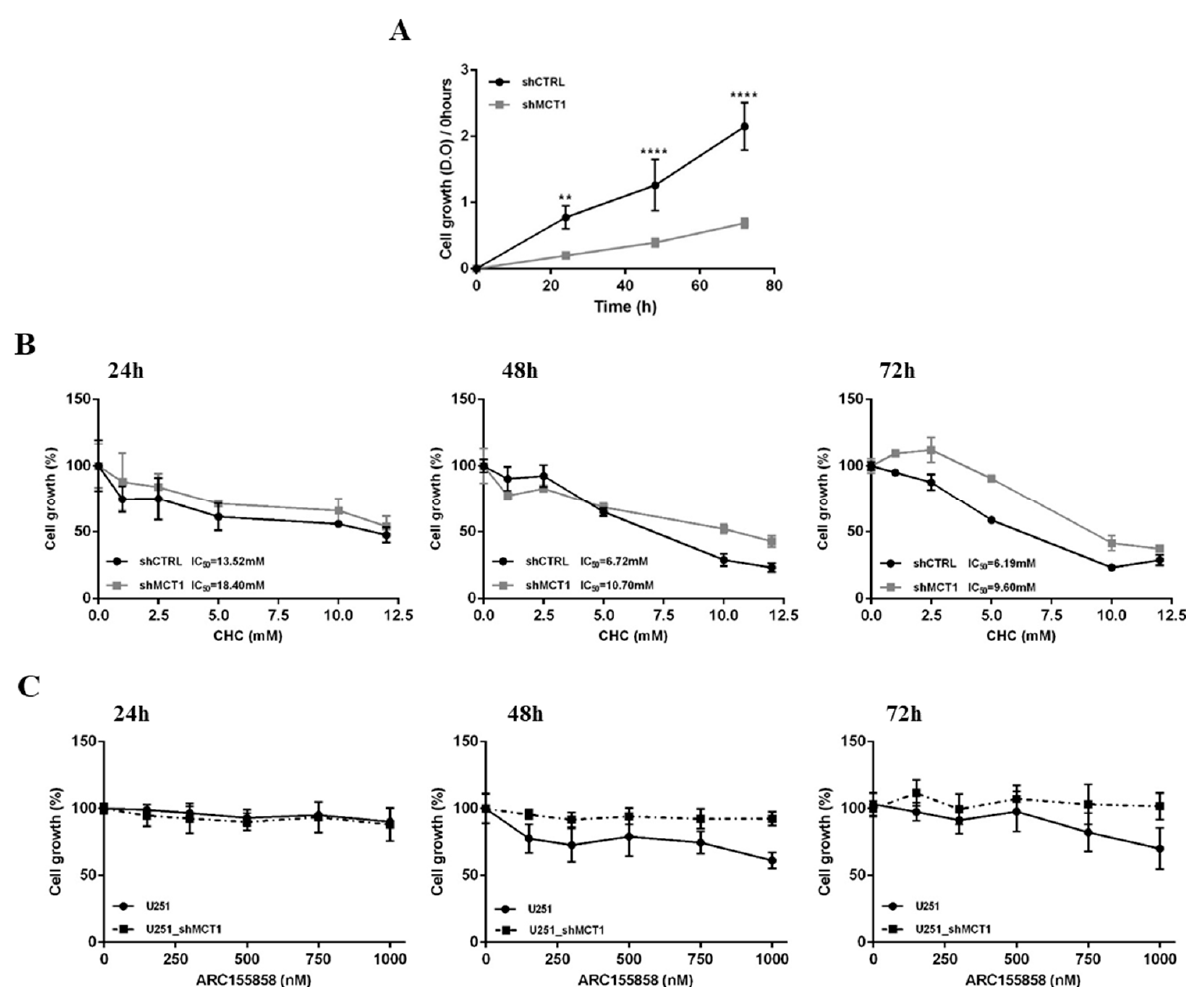
Figure 3. MCT1 downregulation in glioma cell growth, CHC and AR-C155858 response. ( A ) Cell growth of U251 shCTRL and U251 shMCT1 over time. ( B ) Response of U251 shMCT1 cells to CHC by cell viability assay; IC50 values mean are representative of three independent experiments. ( C ) Response of U251 shMCT1 cells to ARC155858 by cell viability assay. Results are representative of three independent experiments, each in triplicate; ** p < 0.01; **** p < 0.0001 U251 shCTRL vs. U251 shMCT1.